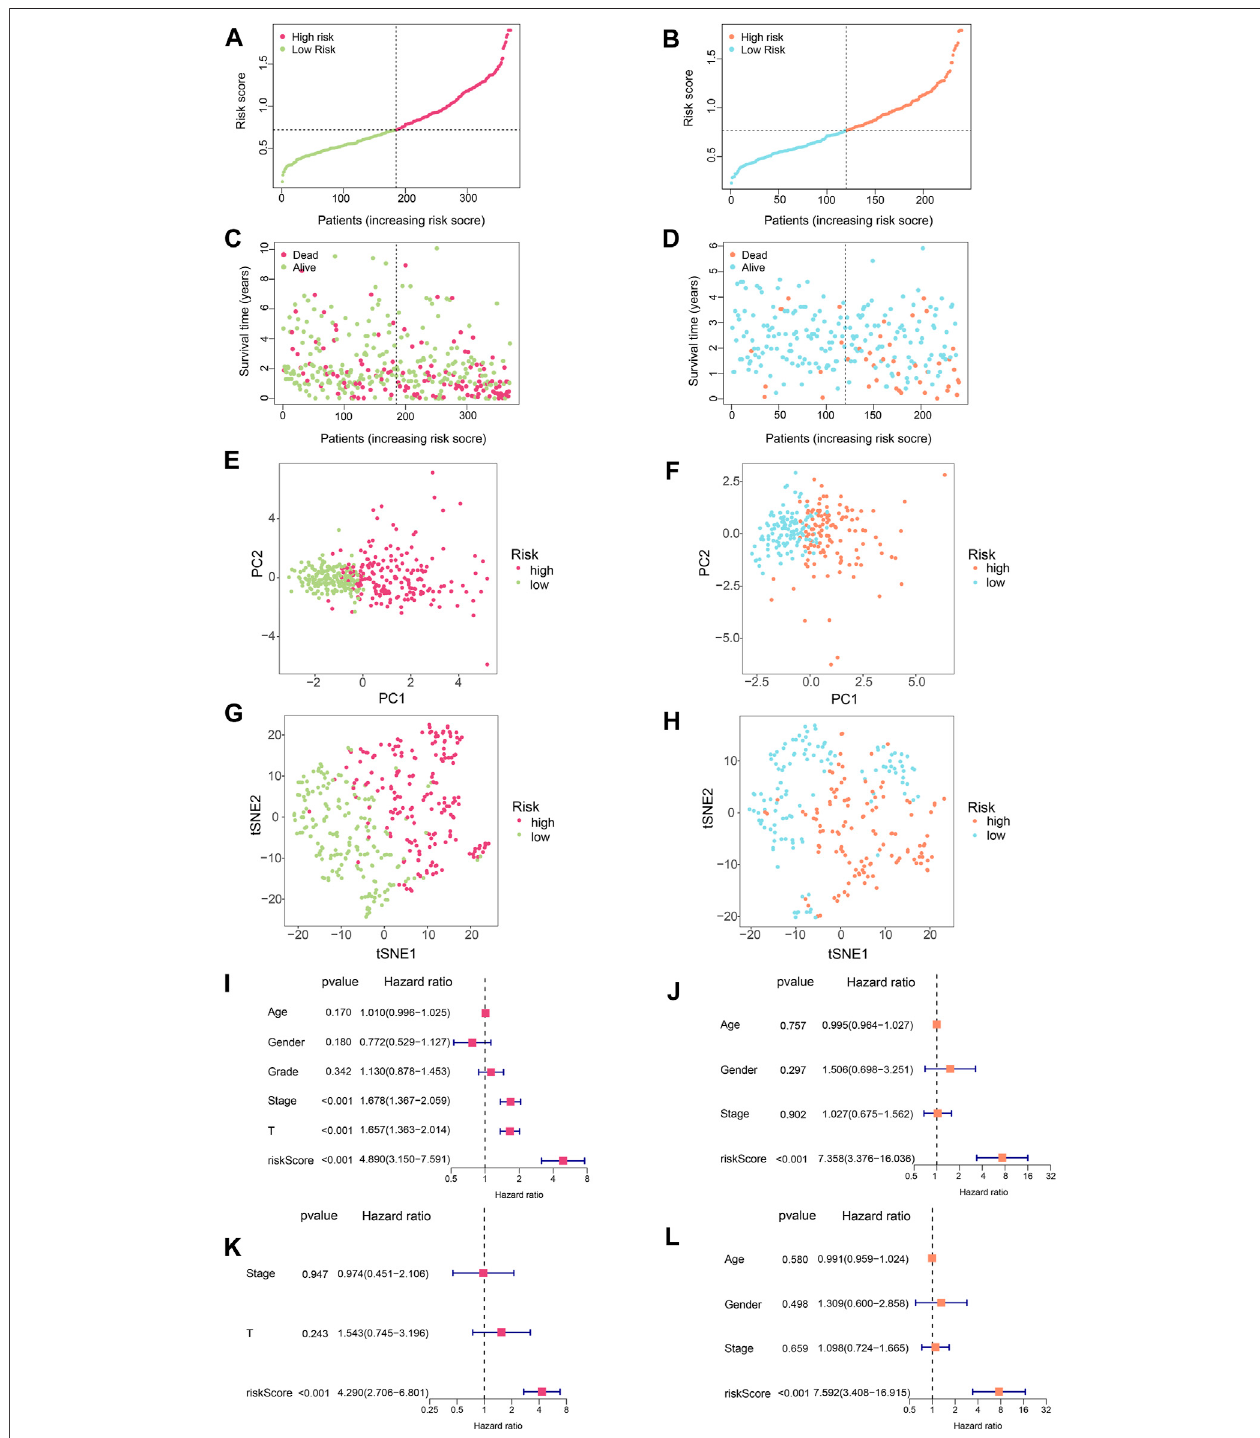
FIGURE3| Further evaluationoftheSLC-related signature. (A) Riskscorecurveoftrainingset. (B) Riskscore curve ofvalidationset. (C) Therelationshipbetween patientsurvivaltimeandriskscoreinthetrainingset.Theresultsshowedthatastheriskscoreincreased,thescatterplotgraduallyconcentrated atthebottom,meaning that the survival time became shorter. (D) The relationship between patient survival time and risk score in the validation set. (E) Principal component analysis (PCA) for training set. The results showed that HCC patients could be well divided into two groups by SLC-related signature. (F) Principal component analysis (PCA) for validation set. The results showed that HCC patients could be well divided into two groups by SLC-related signature. (G) TSNE analysis was performed on the training set. The results showed that HCC patients could be well divided into two groups by SLC-related signature. (H) TSNE analysis was performed on the validation set. The